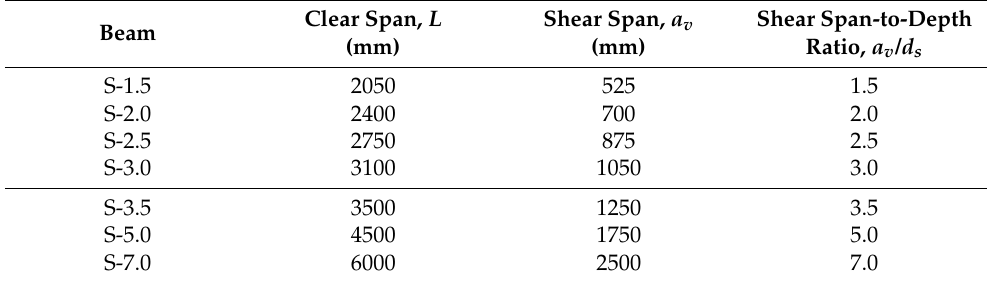
Table 3. Details of the simulated beams that were tested by Al-Saawani et al. [6].